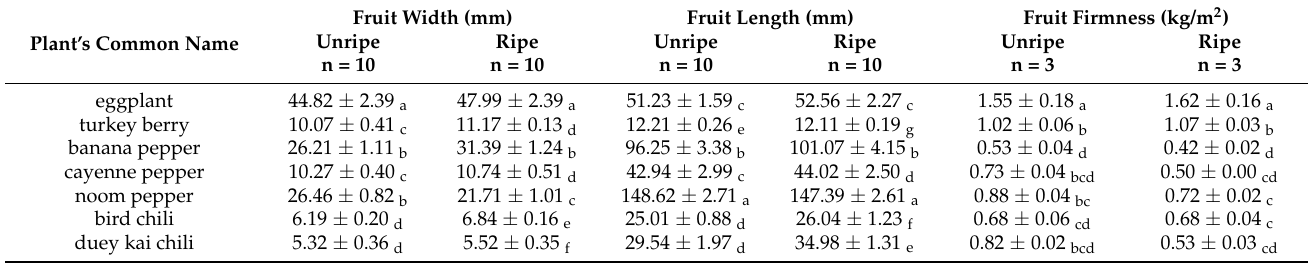
Table 4. Fruit characteristics of seven solanaceous plants used in the